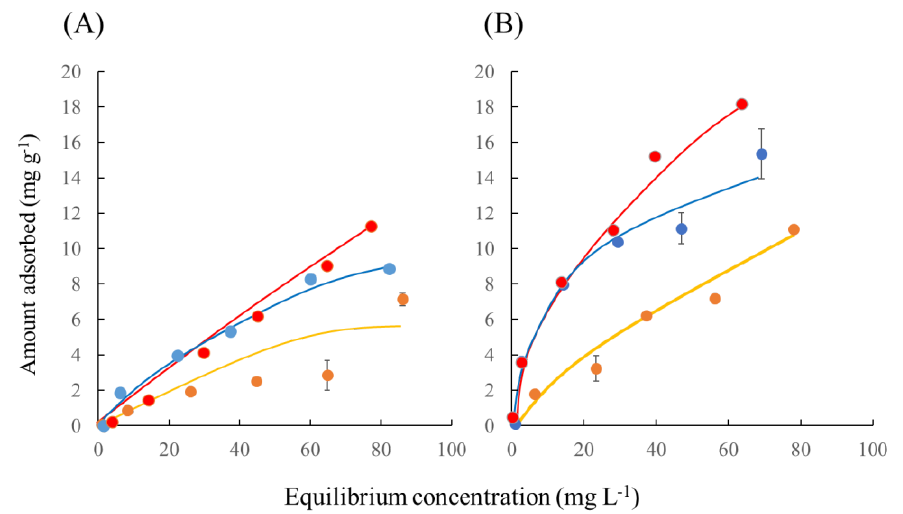
Figure 5. Effect of pH on the adsorption of As(III) using NA11(A) and NAZ1(B). Initial concentration 100 mg L −1 , solvent volume 50 mL, adsorbent 0.1 g, pH 2, 4, 6, 8, and 10, contact time 24 h, temperature 25 °C, agitation speed 100 rpm.